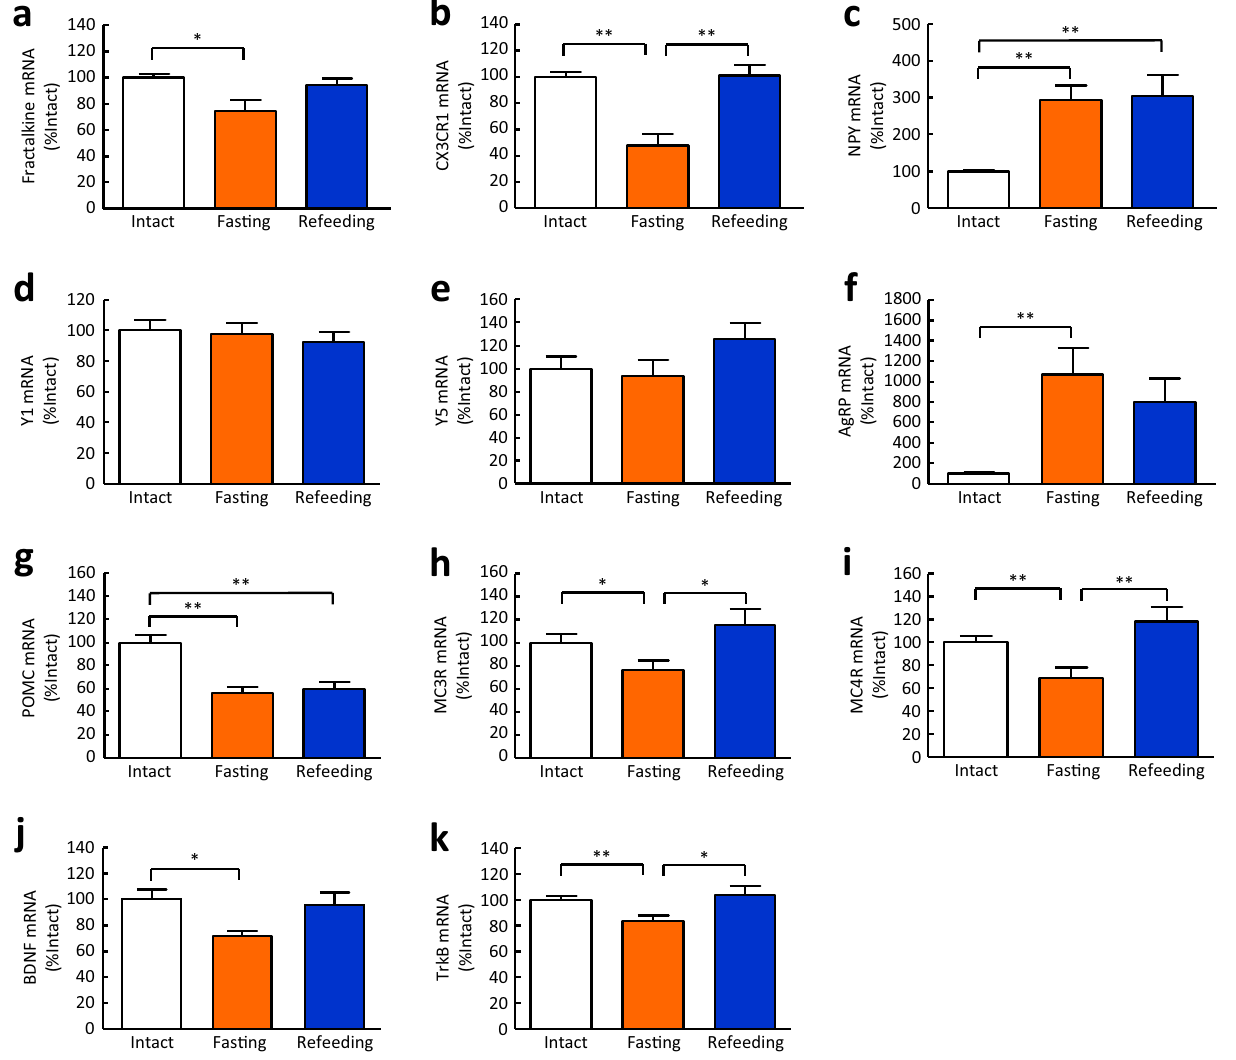
Figure 1. Effects of fasting-refeeding on mRNA expression of fractalkine, CX3CR1, and feeding regulatory peptides and their receptors in the hypothalamus of mice. ( a ) Fractalkine, ( b ) CX3CR1, ( c ) NPY, ( d ) Y1 receptor, ( e ) Y5 receptor, ( f ) AgRP, ( g ) POMC, ( h ) MC3R, ( i ) MC4R, ( j ) BDNF, and ( k ) TrkB were observed in the hypothalamus of mice after 48-h fasting and 4-h refeeding. Results are expressed as mean ± SEM for 6–13 mice. Significant differences: * p < 0.05, ** p <